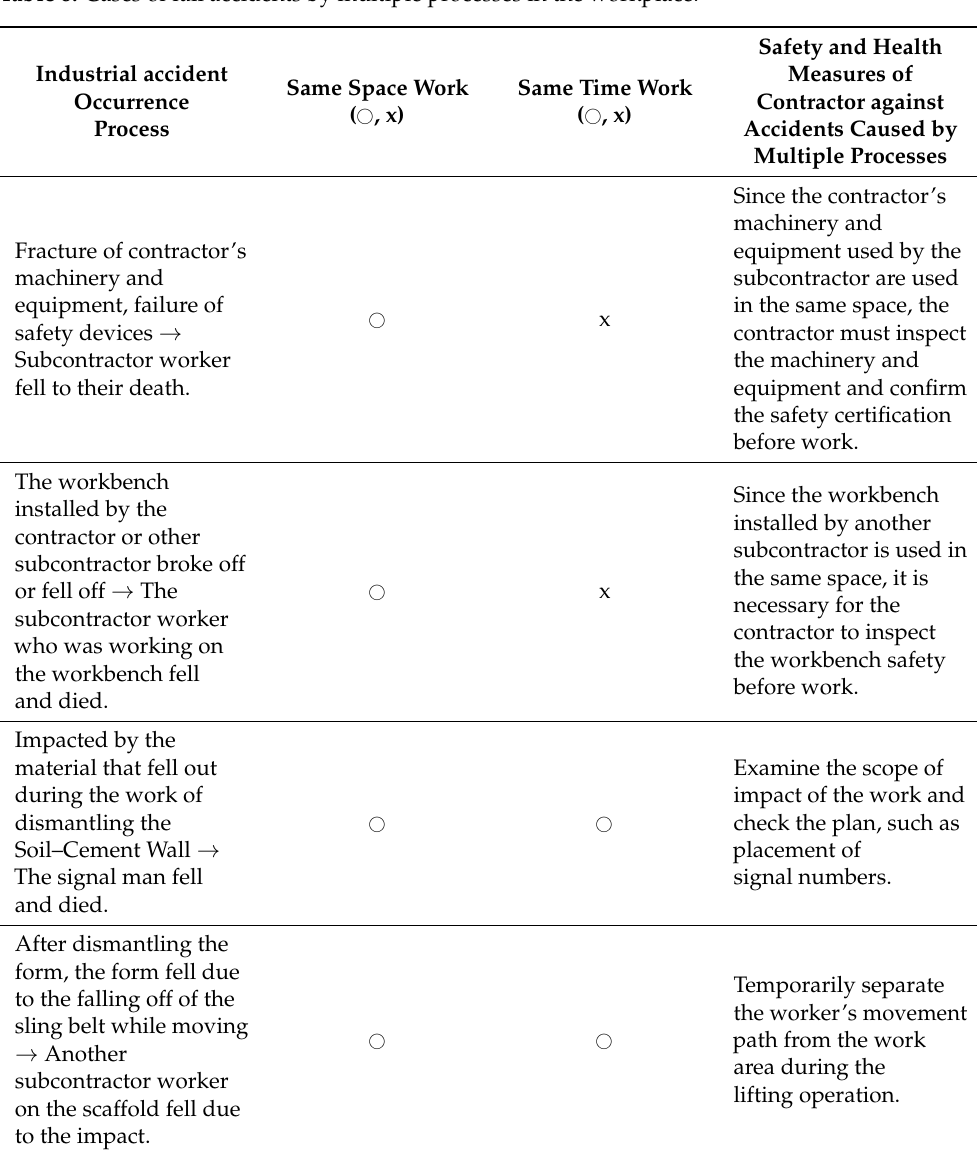
Table 8. Cases of fall accidents by multiple processes in the